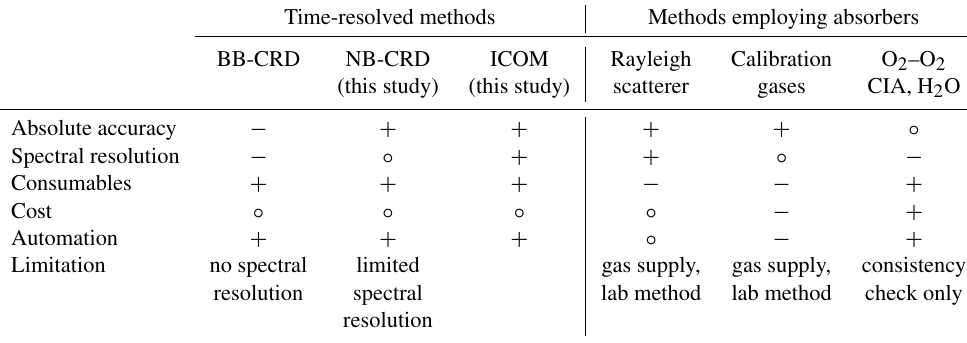
Table 1. Strengths (+), limitations ( − ), and adequate sufficiency ( ◦ ) of current methods for the path length determination in optical resonators. CIA denotes collision-induced